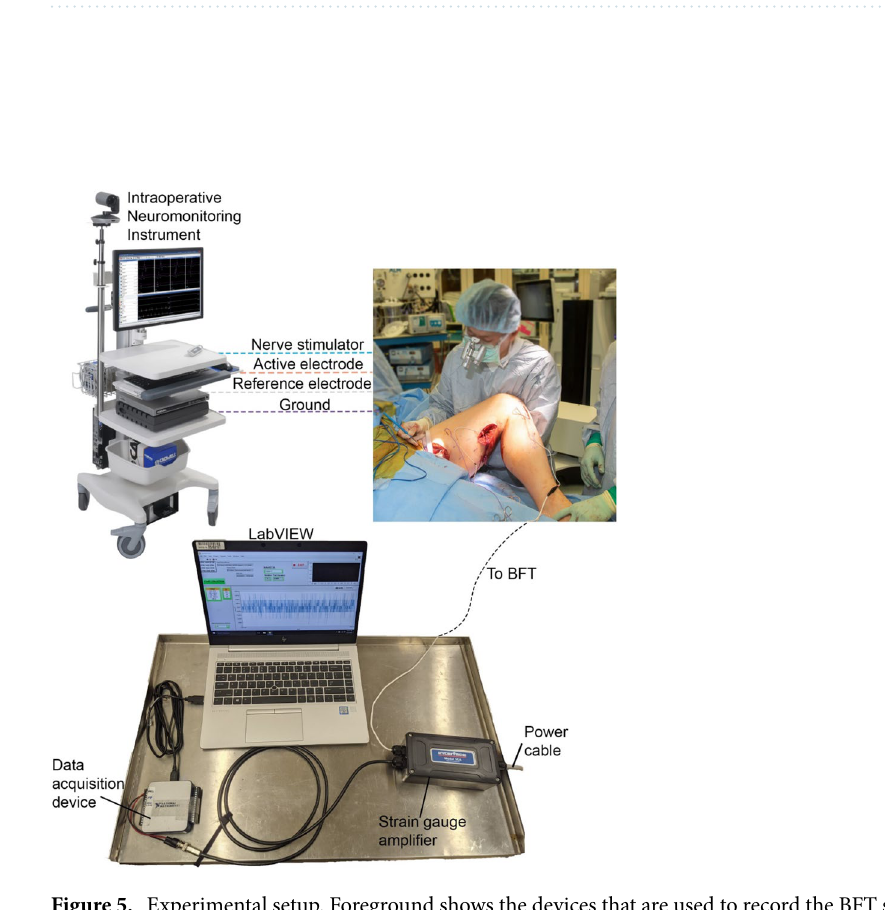
Figure 5. Experimental setup. Foreground shows the devices that are used to record the BFT signal. The BFT cable from the patient is connected to the strain gauge amplifier input. The strain gauge amplifier output is connected to the DAQ which is connected to a laptop via a USB connection. Data collection is performed using LabVIEW. The nerve stimulator and electrodes are connected to an intraoperative neuromonitoring instrument (Cadwell Cascade Pro, Cadwell, Kennewick, WA). Details of EMG electrode placement are described in step 16 and Fig.